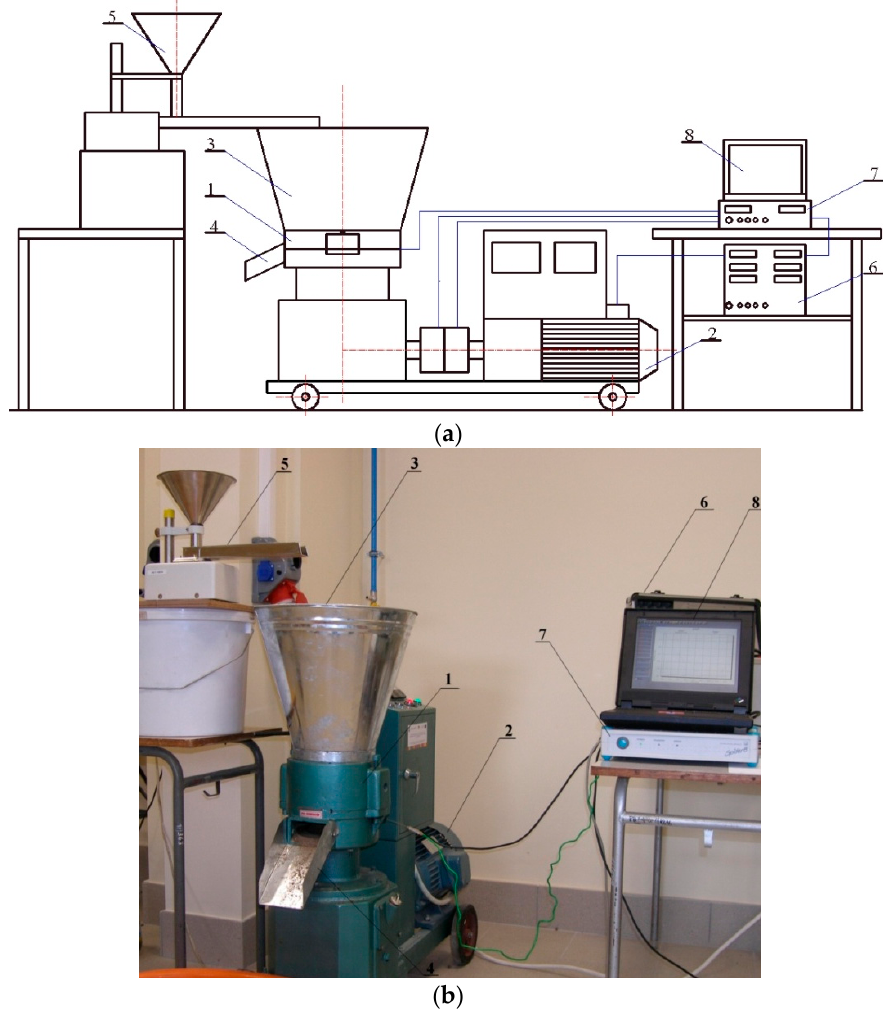
Figure 3. Stand SS-4: ( a ) scheme of the station: 1—working system of granulator with a flat matrix, 2—electric motor driving the granulator (Y132M, 7.5kW, 1440obr ∙ min − 1 ), 3—feed of raw material, 4—spill granulate, 5—vibrating dispenser (FRITISCH LABORET 24), 6—universal meter for measuring the power demand (METROL KWS 1083, max 20kW0), 7—recorder Spider 8, 8—PC computer; ( b ) view of the laboratory stand.